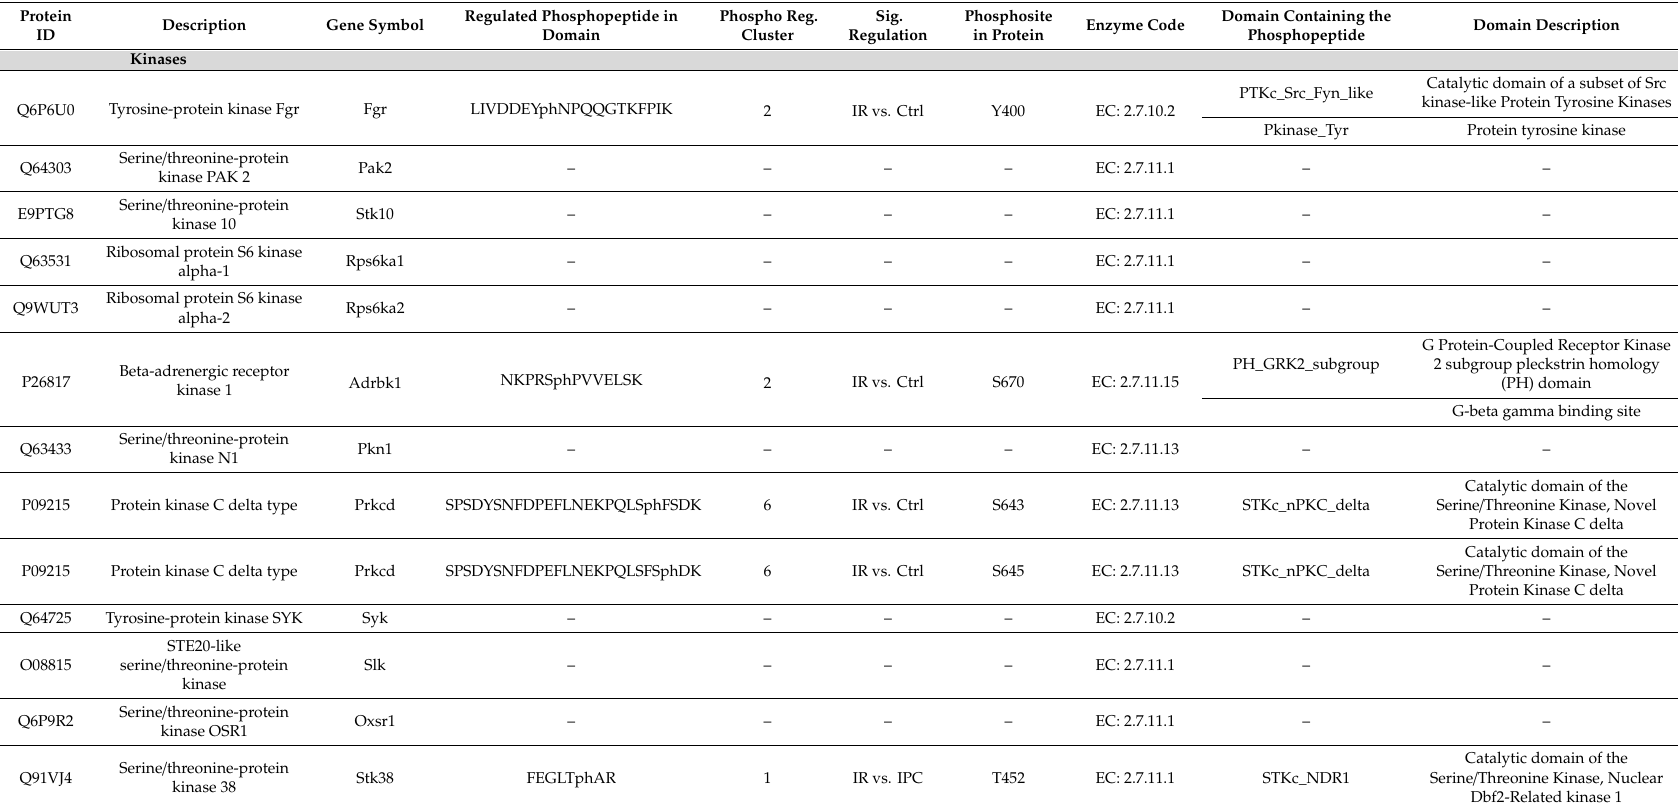
Table 1. Kinases and Phosphatases with regulated